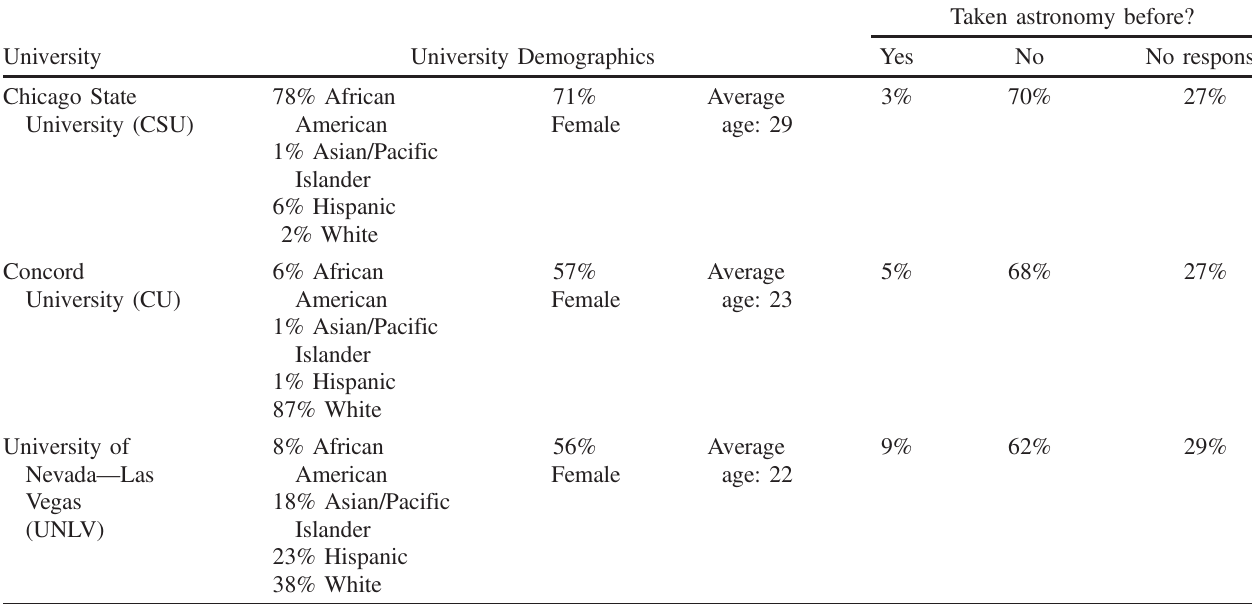
Taken astronomy before?